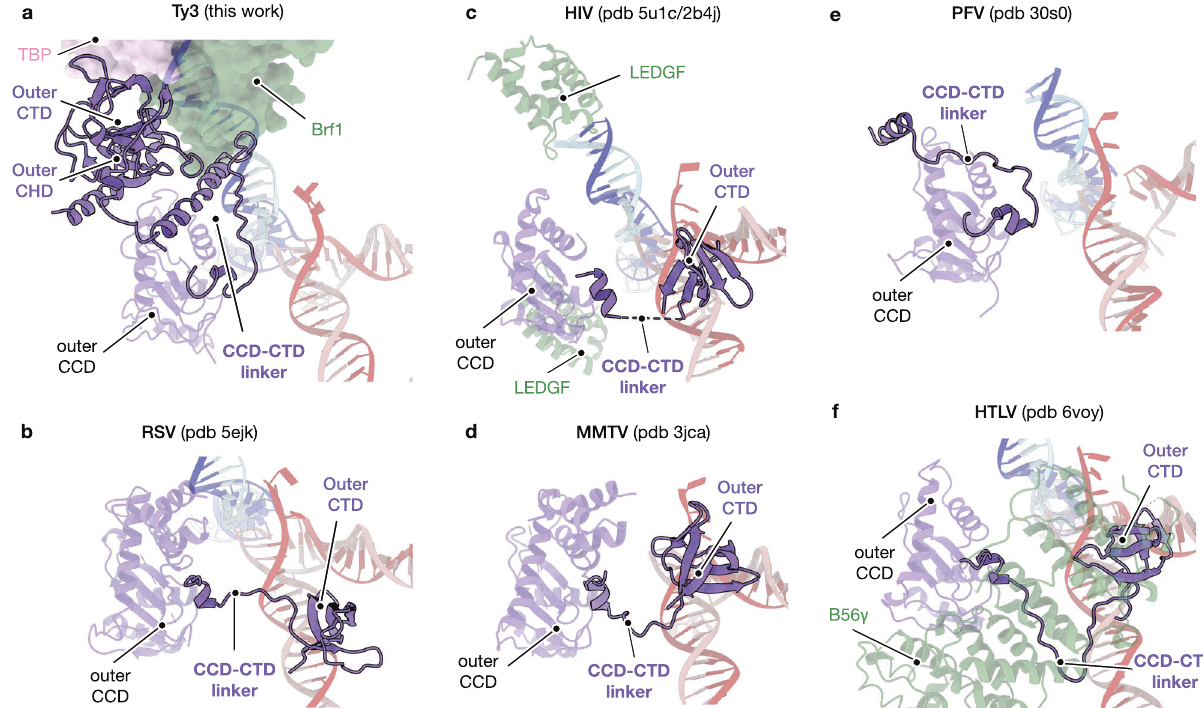
Fig. 5 Ty3 CCD-CTD extended linker creates a platform for TFIIIB assembly. a Detailed view of the orientation adopted by the CCD-CTD linker of Ty3 integrase outer subunit. Ty3 extended linker adopts a peripheral orientation that creates a platform for the interaction between Ty3 CTD and CHD domains (purple ribbon) and TFIIIB transcription factor (pink and green surfaces). The outer catalytic core domain (CCD) and the DNA molecules are shown as transparent ribbons. b As in a but for Respiratory Syncytial Virus (RSV, PDB code: 5EJK). c As in a but for Human Immunode fi ciciency Virus (HIV, PDB code: 5U1C). Binding of LEDGF/p75 transcription factor (green ribbon) to HIV could be mediated by a similar region than in the Brf1-IN interaction, which highlights a potential hot-spot for host-integrase recognition events. d As in a but for Mouse Mammary Tumor Virus (MMTV, PDB code: 3JCA). e As in a but for Prototype Foamy Virus (PFV, PDB code: 3OS0). f As in a but for Human T-lymphotropic Virus Type 1 (HLTV, PDB code: 6VOY). Binding of CCD-CTD linker to B56 γ (green ribbon) is